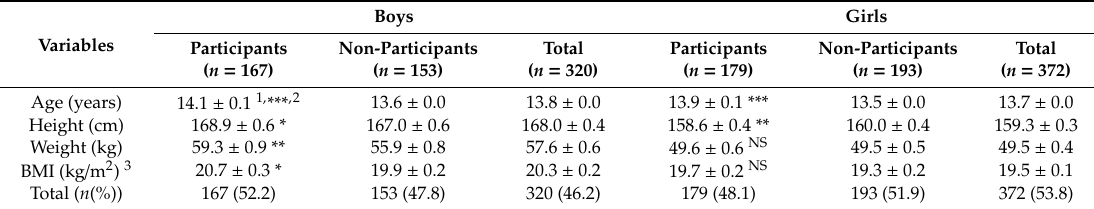
Table 1. Anthropometric characteristics of participants and non-participants in the school milk program in South